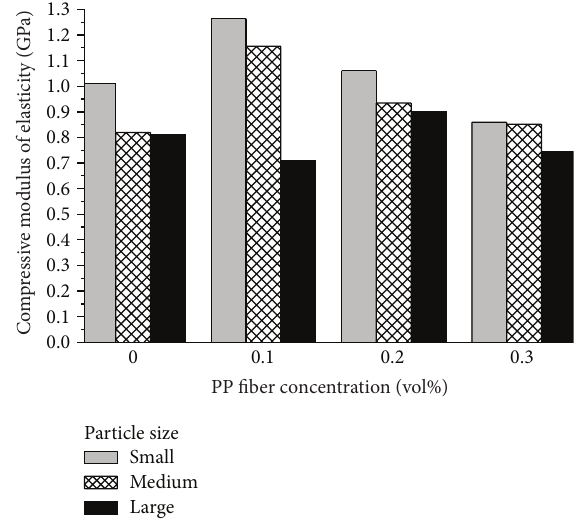
Figure 5: Compressive modulus of elasticity of polymer concrete with different marble particle sizes and fiber